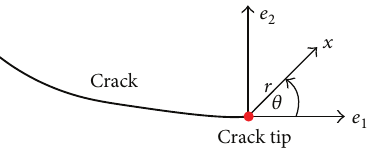
Figure 4: Polar coordinate system associated with a crack